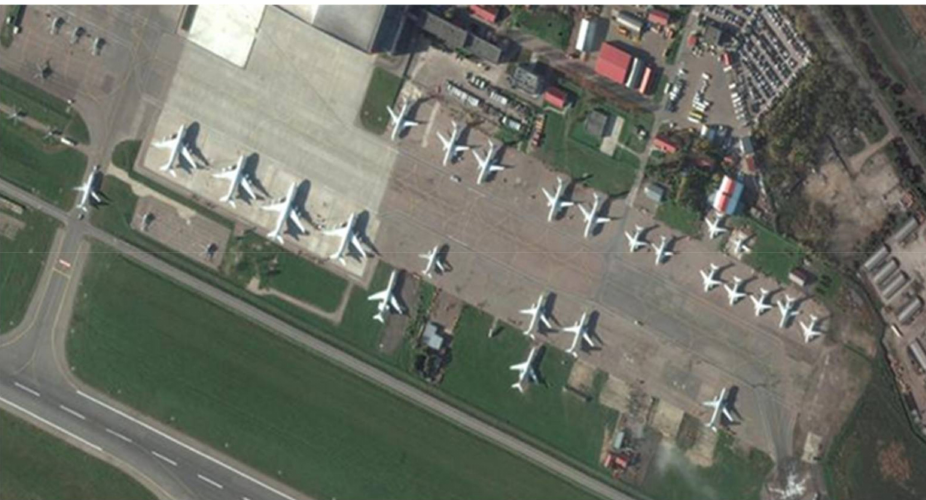
Figure 2. This satellite image is taken by Google Earth. It is an open-source platform for collection of satellite images. This image contains objects of interest, i.e.,